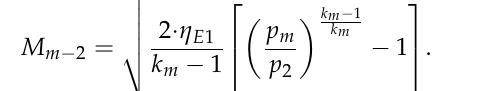
Figure 5. Function: 𝜔 = 𝑓(𝑝 (cid:2870) ) parametric in η D . The values of the entrainment ratio ω ind presented in Table 1 concern high-perfor- mance industrial ejectors, in which the manufacturer has also foreseen the correct acceler- ation of the induced stream in the suction chamber to obtain the high entrainment ratio 0.000.200.40 0.600.80 1.001.20